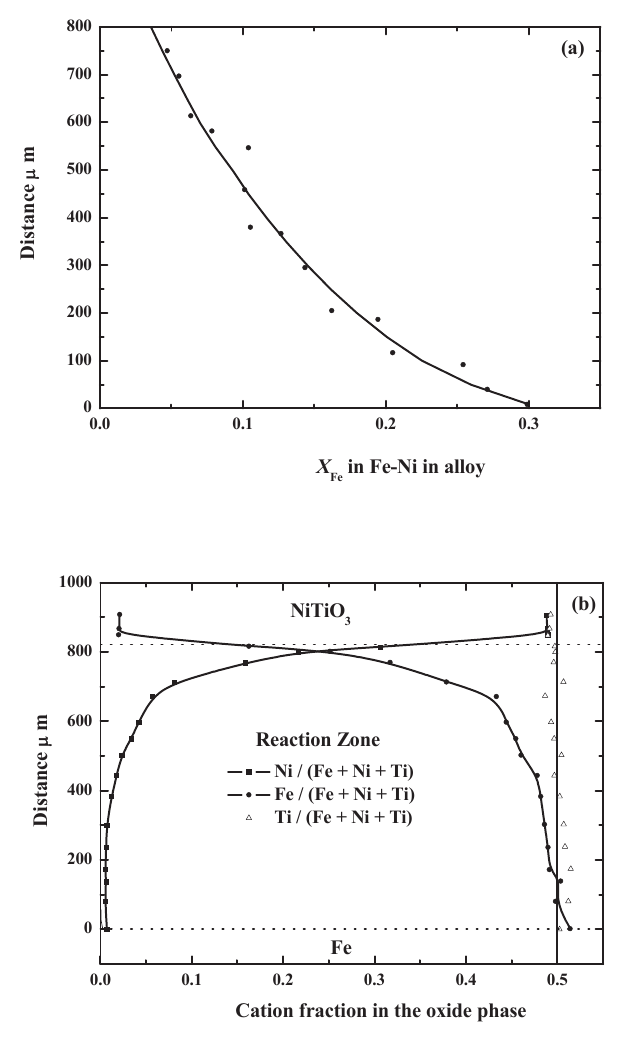
Figure 2. Composition of the (a) alloy and (b) oxide phases in the product layer formed by the reaction of Fe with polycrystalline NiTiO 3 at 1273 K after 230.4 ks